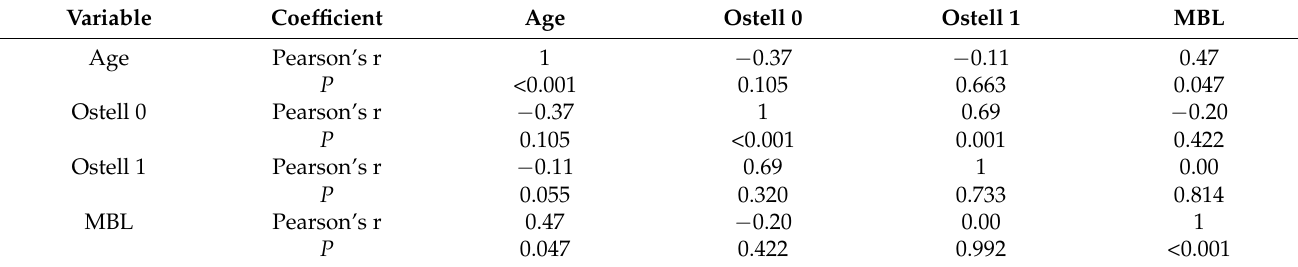
Table 4. Linear correlation coefficients for group two and their significance for the selected continuous variables.